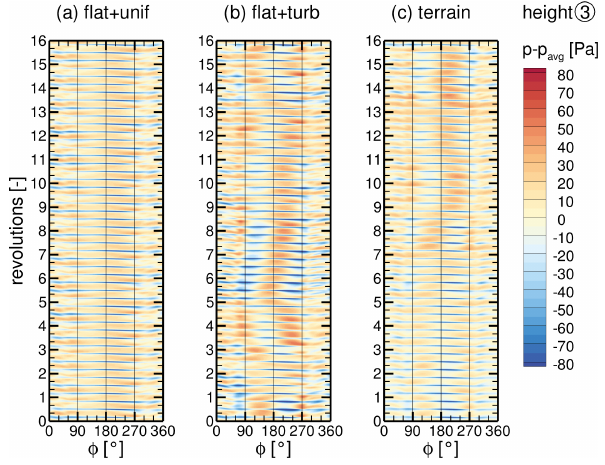
Figure 20. Power spectral density of surface pressure fluctuations on a line around the tower at height (3) for all cases (a) – (c)